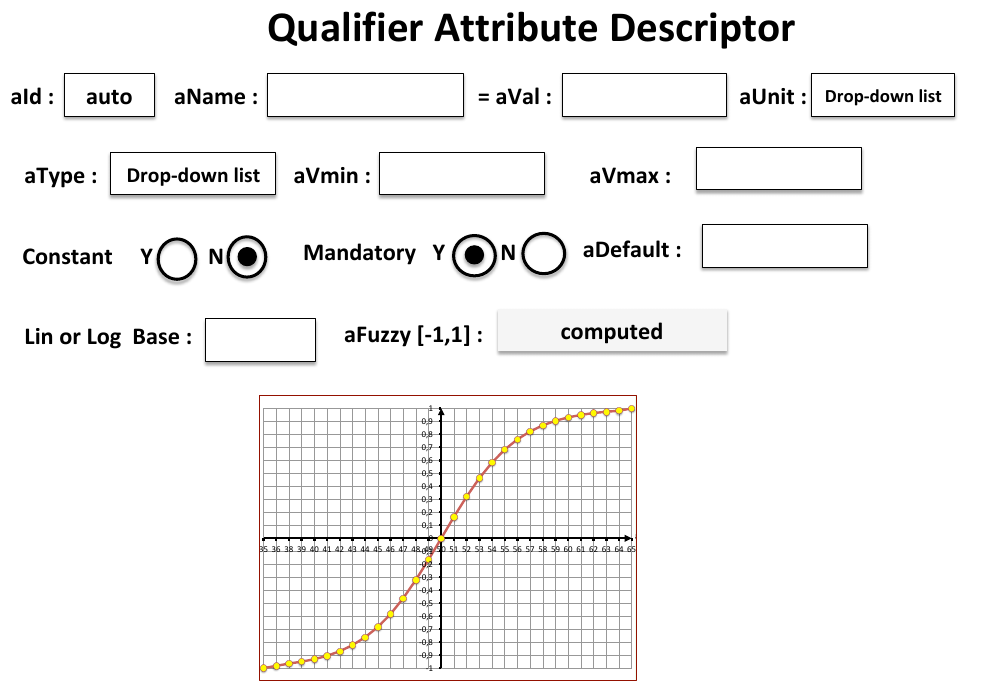
Figure 7. Expert interface: qualifier attribute descriptor interface